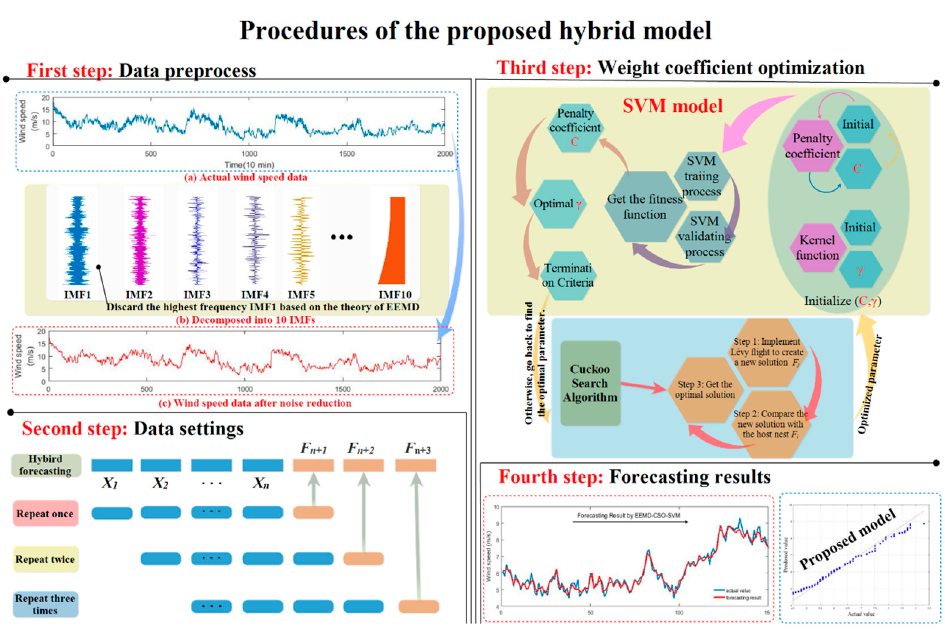
Figure 2. The flowchart of the proposed forecasting method.